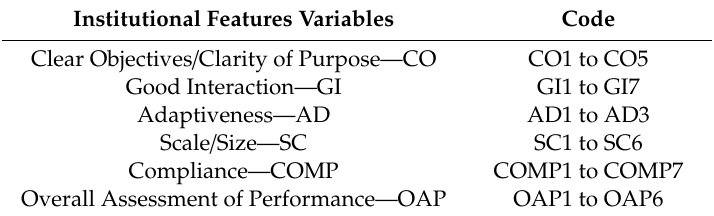
Table 2. Coding of the institutional features used in the